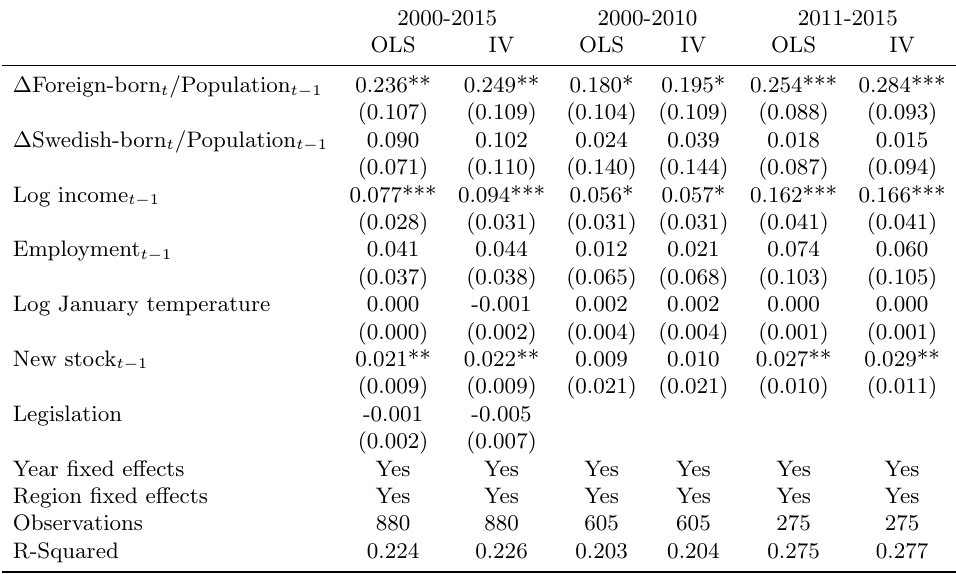
Table 2: The relationship between migration and rental levels over different time